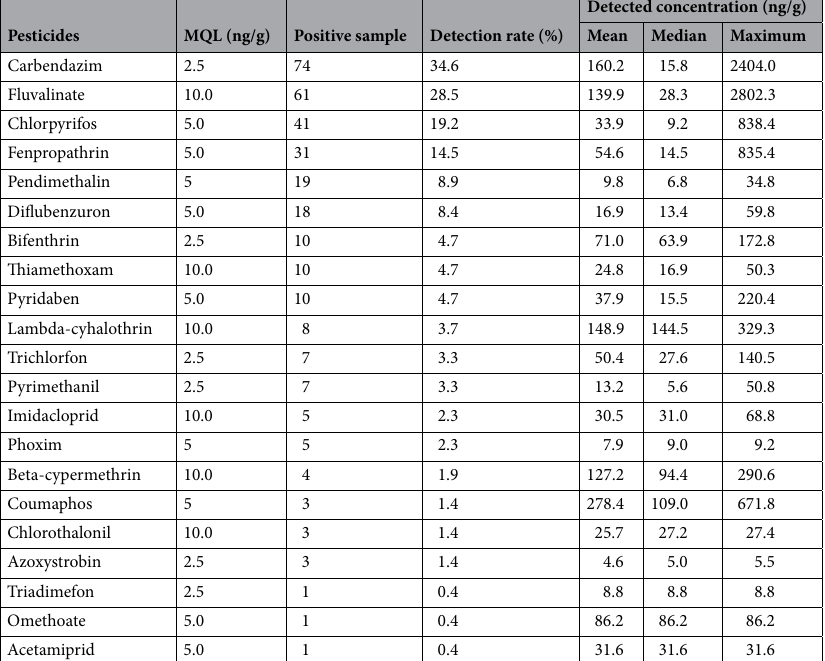
Table 1. The frequencies of detection and concentration of pesticide active ingredients in honeybee samples.